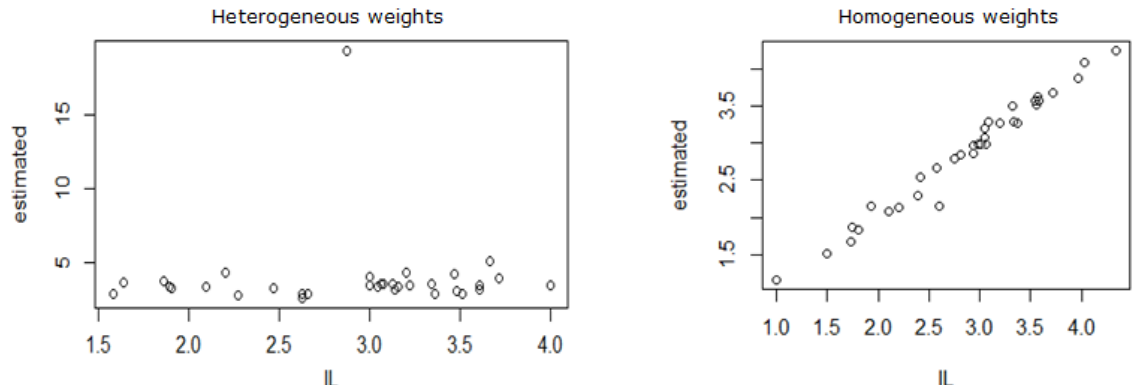
Figure 4. Comparison of the correlation graphs of the estimated response variable of networks trained with heterogeneous and homogeneous